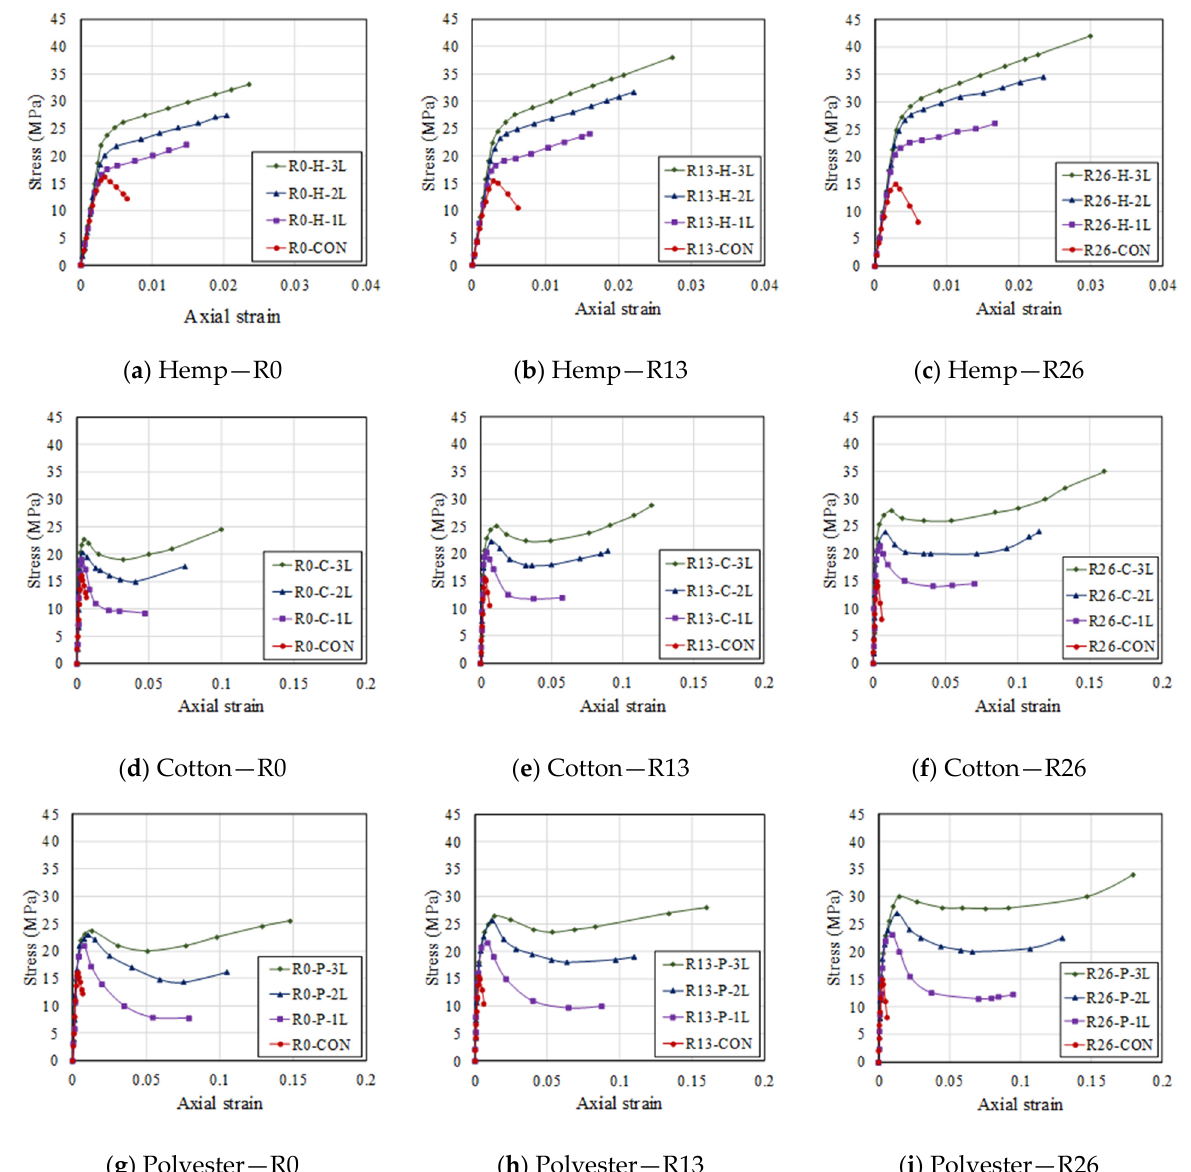
Figure 7. Stress versus axial strain curves of FRRP-confined specimens.